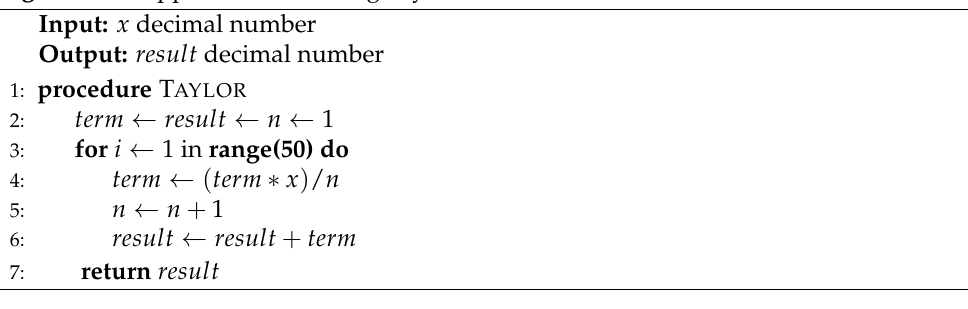
Algorithm 4 Approximate e x using Taylor Maclaurin series